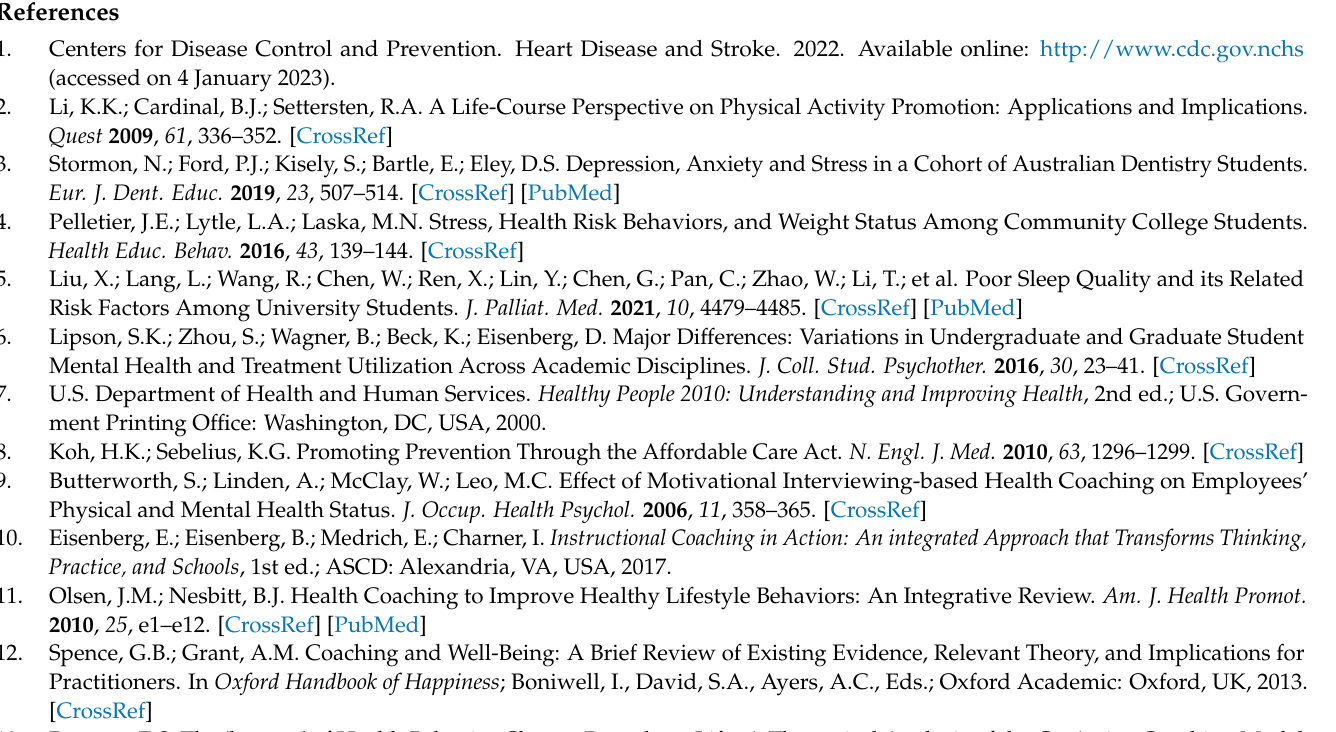
Figure A1. Intervention flowchart